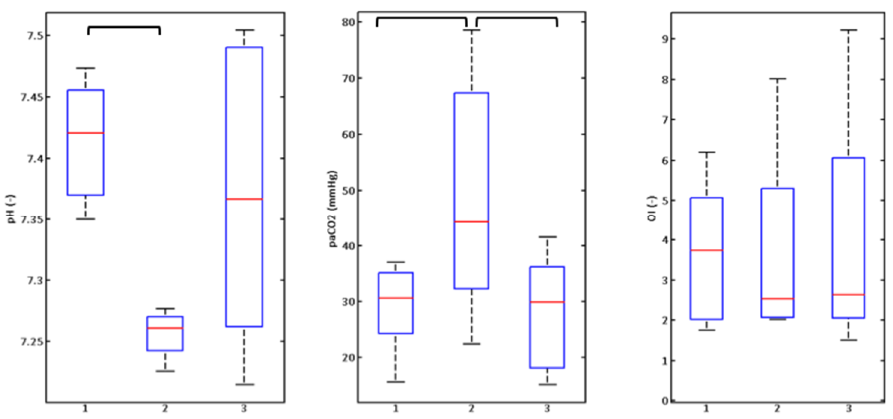
Figure 9. Graphic illustration of monitored parameters of rabbits ( n = 8) at a respiratory rate of 240 breaths/min.